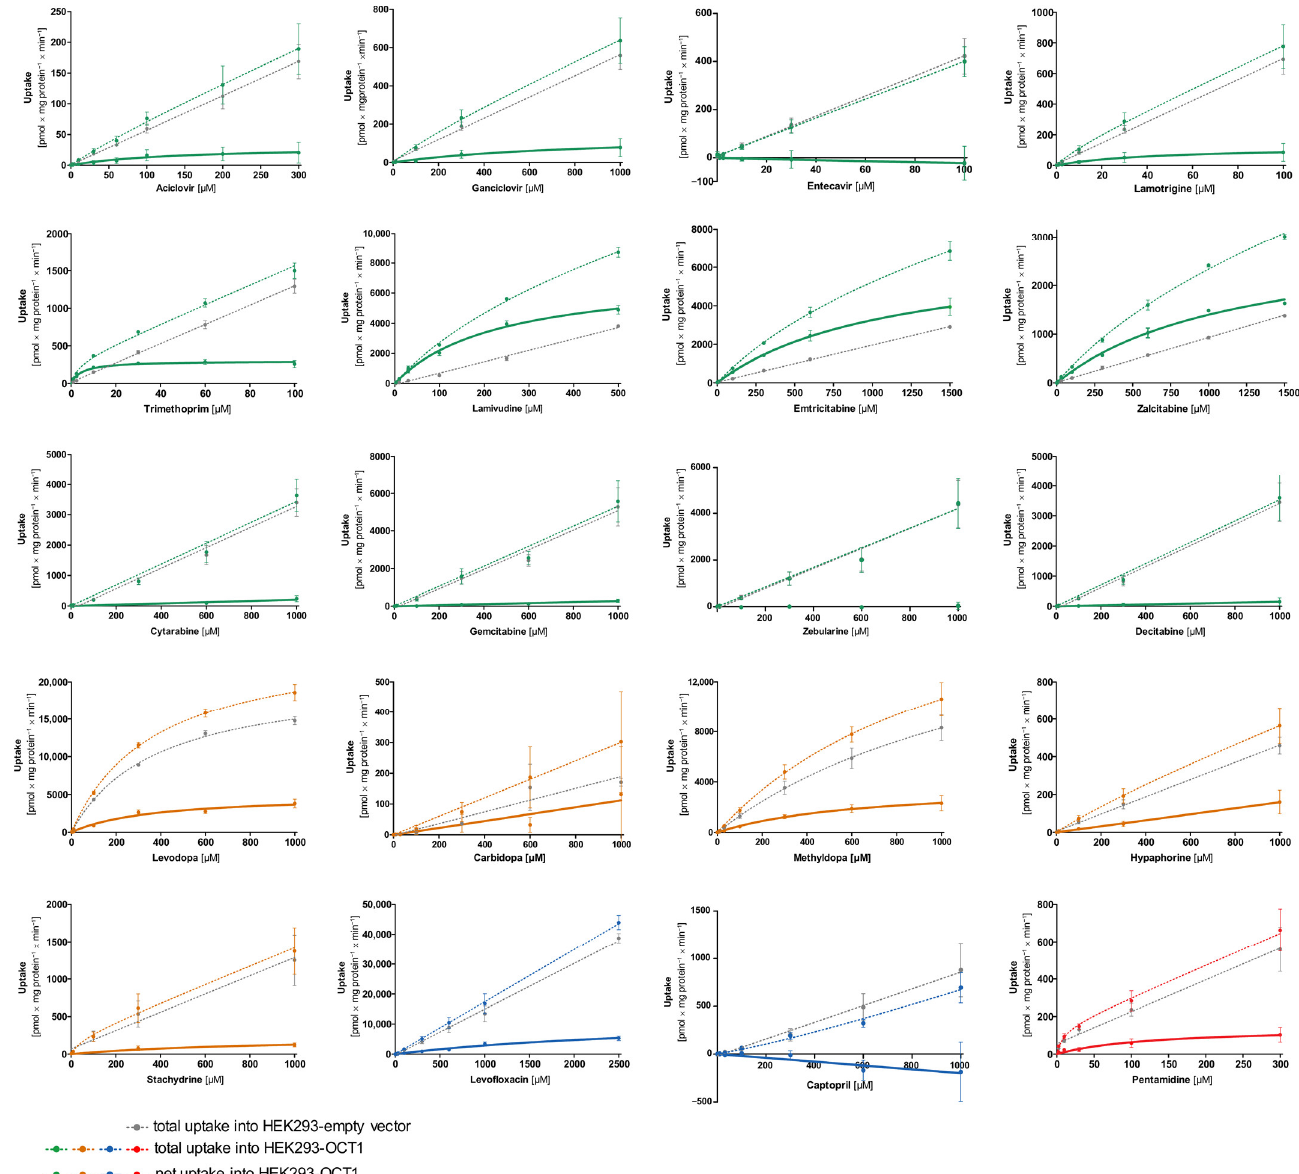
Figure 4. Concentration-dependent uptake of potential substrates of OCT1. HEK293 cells that were transfected stably with the OCT1 transporter were incubated with the candidate substrates. The total uptake of various concentrations of the substances within the time range indicated in Table 1 by OCT1 (coloured – dotted curve) and empty vector overexpressing HEK293 cells (grey – dotted curve) are shown. The bold curve shows the net uptake which is calculated by subtraction of the total uptake by empty vector-transfected cells from the total uptake by OCT1-transfected cells (coloured – straight curve). The data points are displayed as means ± SEM. The experiments were conducted at least three times (n ≥ 3) independently from each other for every substance.